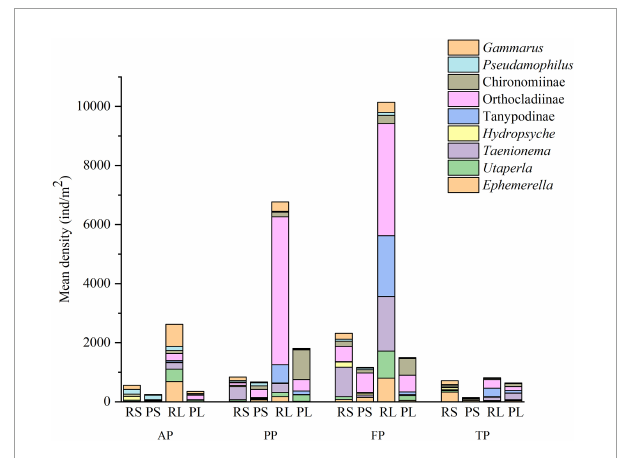
FIGURE4 Change in the mean density of main groups that caused spatial and temporal differences of community composition via similarity percentages (SIMPER) analysis. RS, riffle stones; PS, pool sediments; RL, riffle litters; PL, pool litters; AP, autumn period; PP, pre-freezing period; FP, freezing period; TP, thawing period.